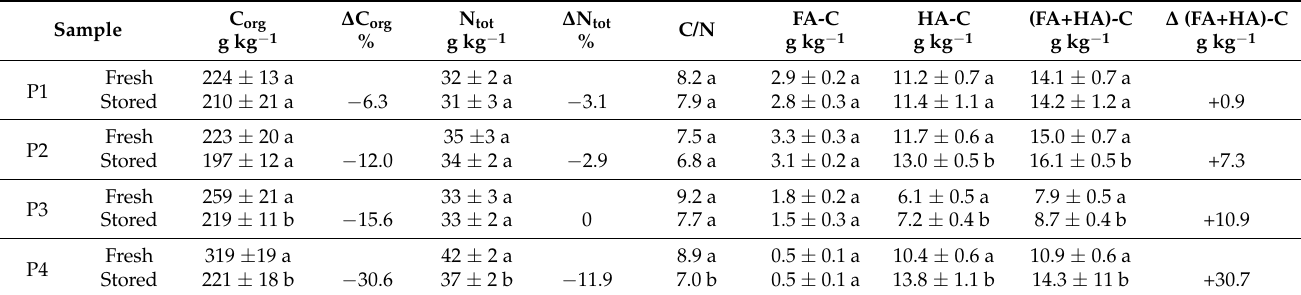
Table 2. Elemental composition and content of C org , FA-C, HA-C, and (FA+HA)-C in sewage sludge samples and percentual changes in C org , N tot , and (FA+HA)-C following storage. Different letters (a, b) refer to significant differences (HSD test, P < 0.05). All data are expressed on a dry weight